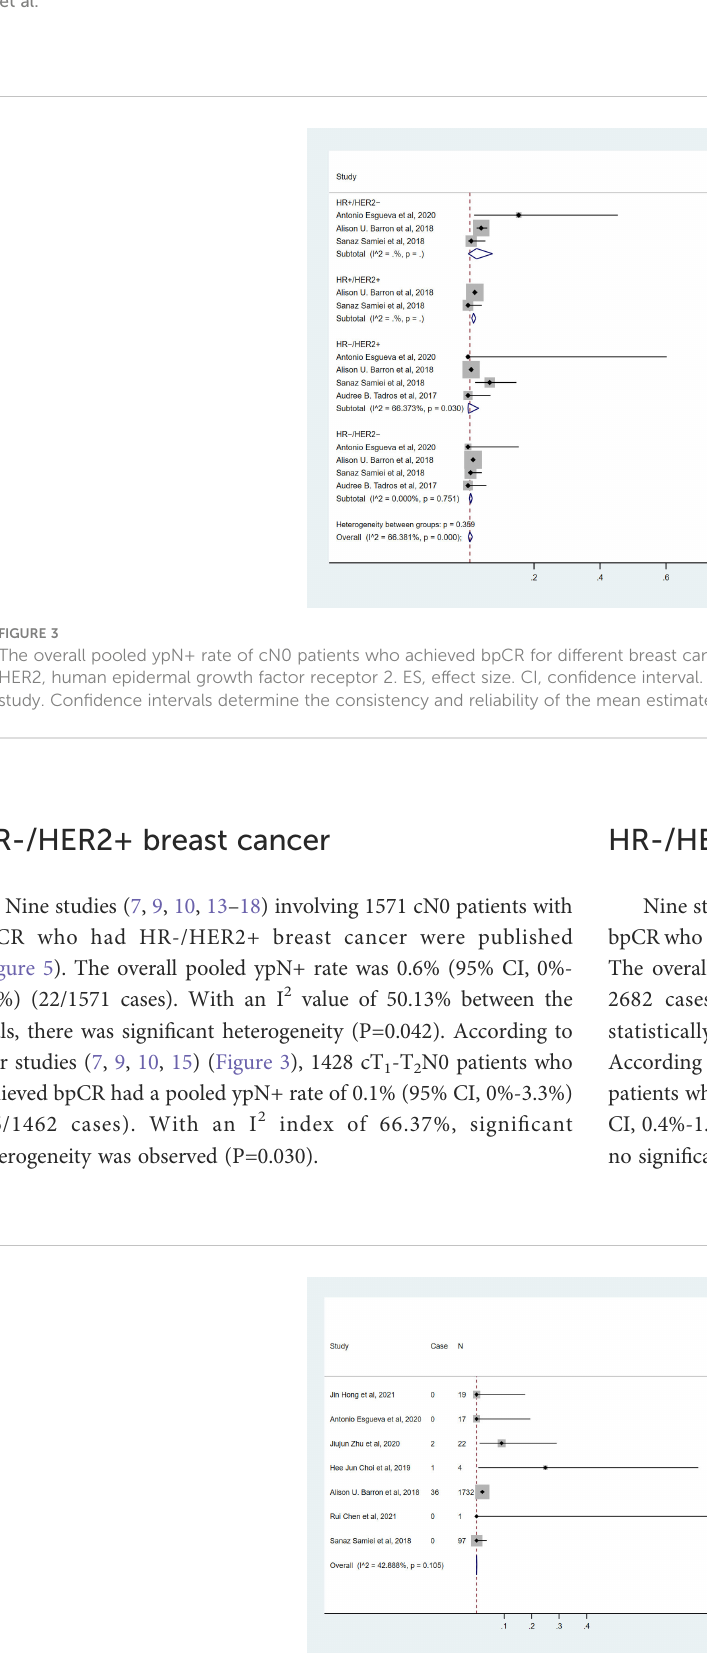
FIGURE 4 The overall pooled ypN+ rate of HR+/HER2+ breast cancer cN0 patients who achieved bpCR. HR, hormone receptor; HER2, human epidermal growth factor receptor 2. ES, effect size. CI, con fi dence interval. Effect size was used to estimate the ypN+ rate of each study. Con fi dence intervals determine the consistency and reliability of the mean estimated effect size. Diamonds indicate effect